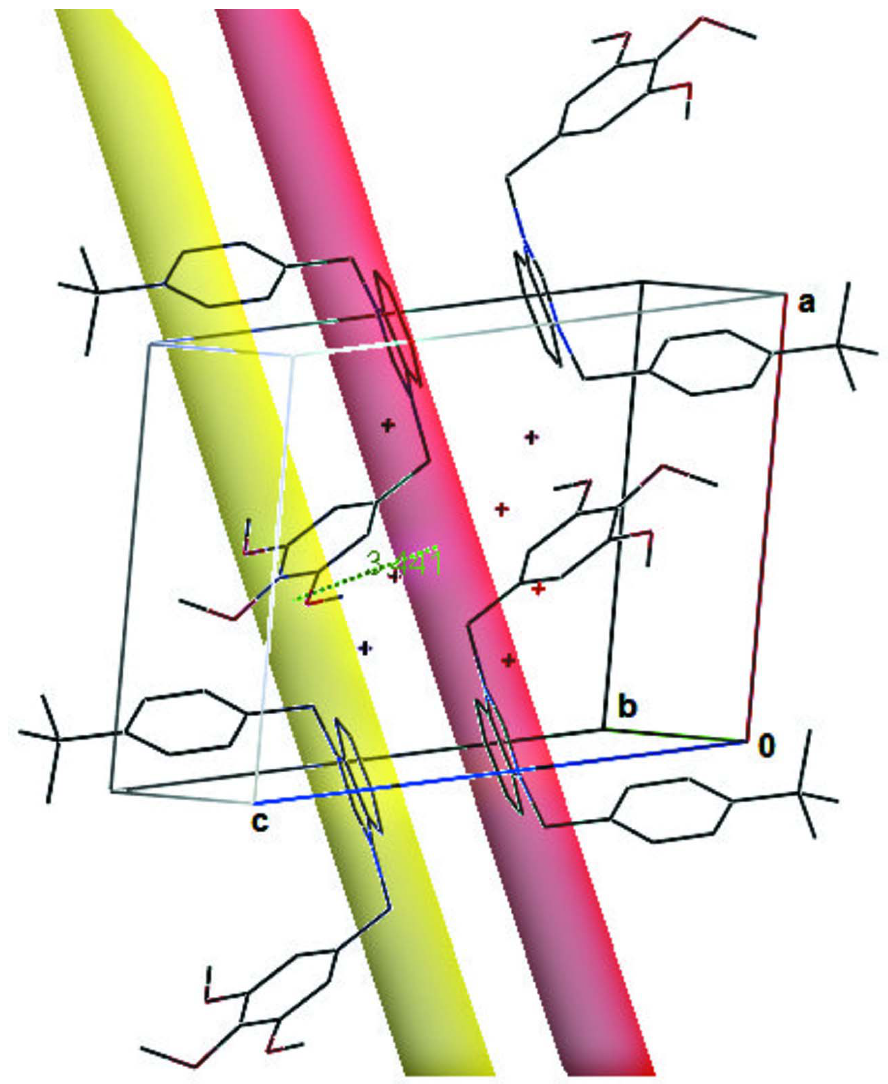
Figure 2 A packing diagram for